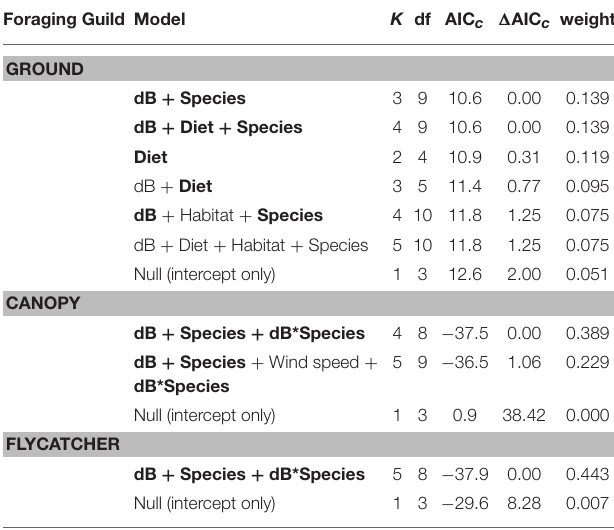
Allmodelsincludelocationasarandomeffect.Kindicatesthenumberofparametersinthe model. Model parameters include background sound level (dB), diet (e.g., omnivorous), habitat (either developed or natural), species, wind speed, and an interaction between background sound and species (dB * Species). Bolded variable names indicate predictors with 95% confidence intervals that do not overlap